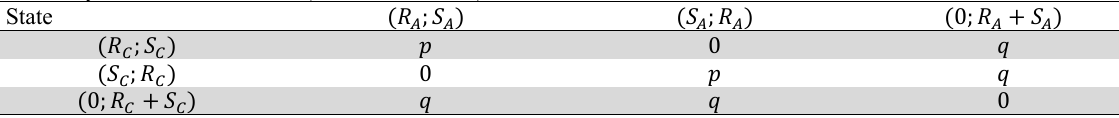
Probability distribution of shock (Fecht et al .,